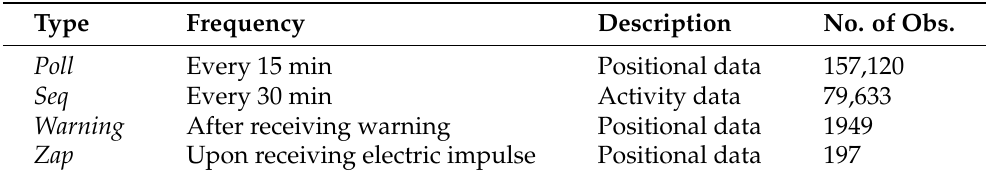
Table 1. Overview and description of data collected for the data analysis with each message type sent from the Nofence© collars. Type Frequency Description No. of Obs. Every 15